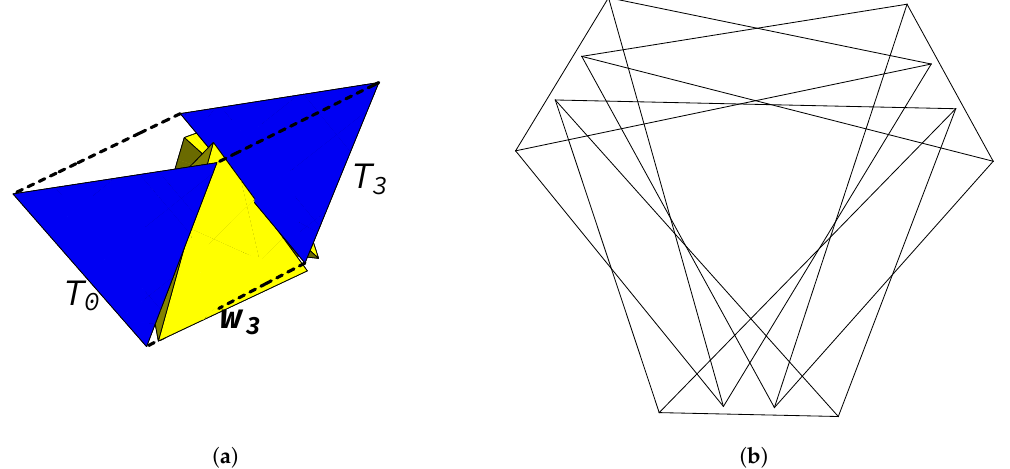
Figure 6. The periodicity of the 3-BC helix: ( a ) the vertices of T 3 are the vertices of T 0 translated by w 3 ; ( b ) a projection of the 3-BC helix along its central